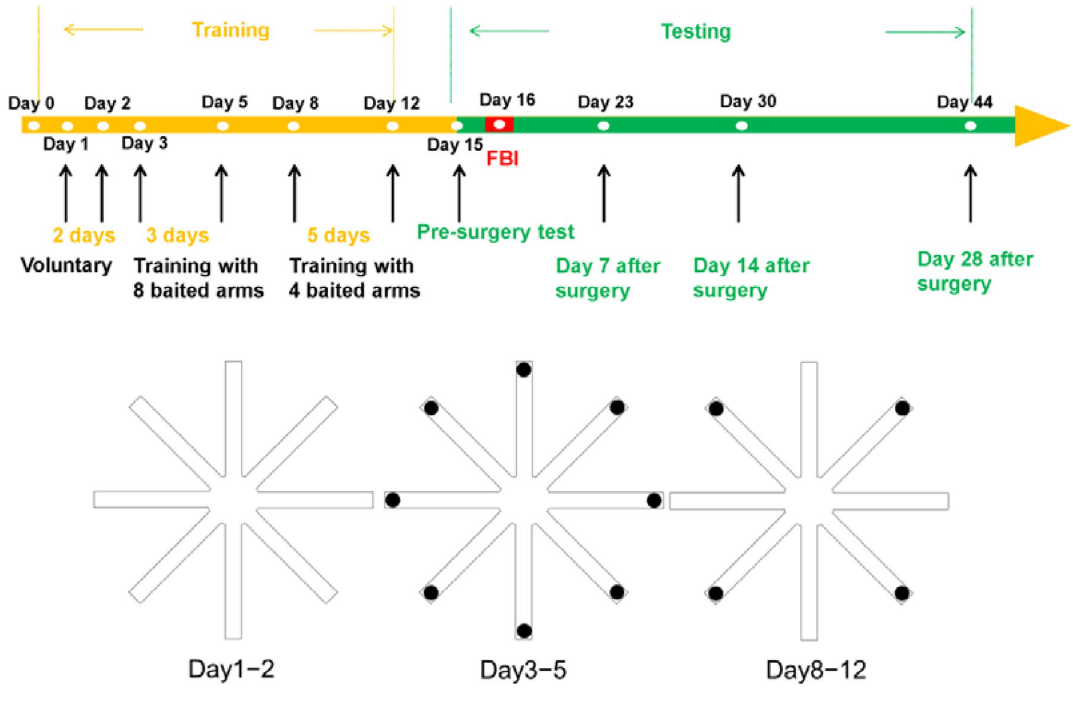
Figure 10. A RAM experimental